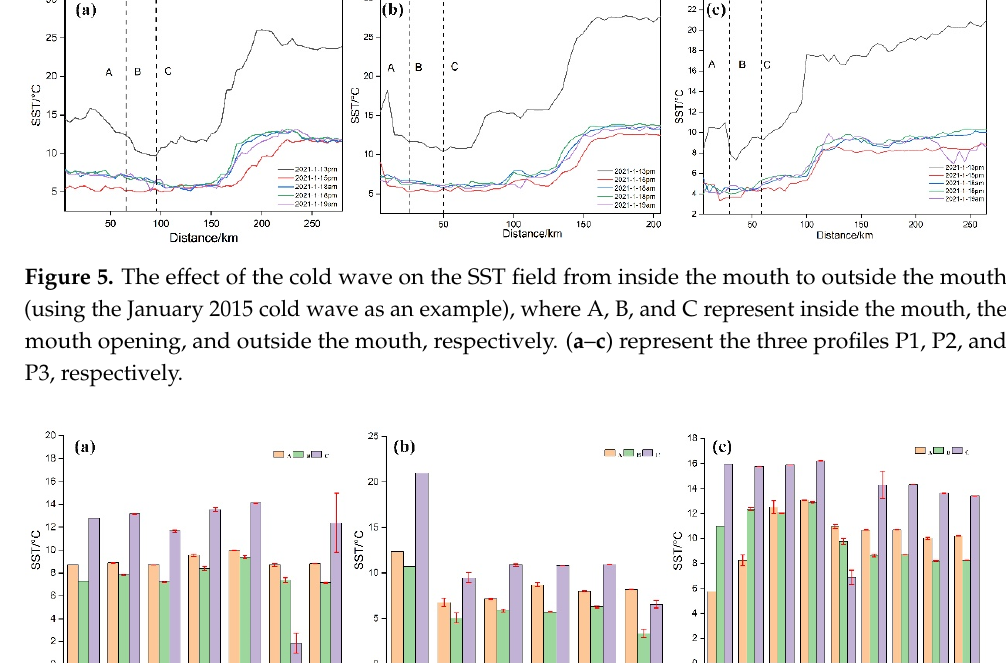
12 of 20 Figure 4. Frontal intensity (°C/km) and spatial variation of temperature fronts in the Yangtze Estu ‐